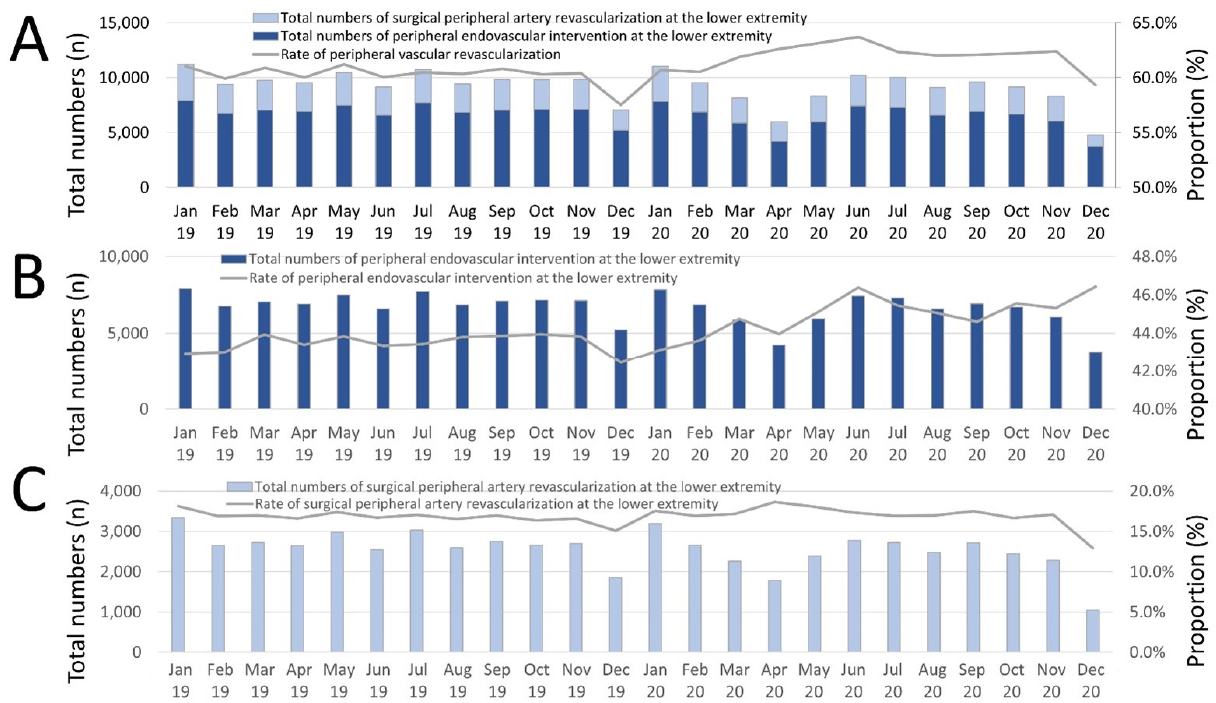
Figure 2. Temporal trends regarding absolute numbers of hospitalizations due to PAD and revas- Table 1. Patients’ characteristics, medical history, presentation and outcome of the included 361,029 cularization treatments. ( A ) Temporal trends regarding absolute numbers of hospitalizations hospitalizations of patients admitted due to PAD 2019 and 2020.